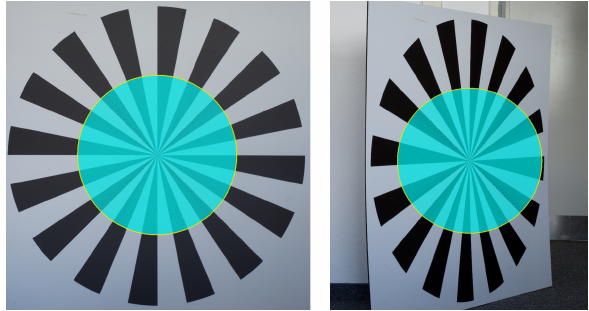
Figure 2. Orthogonal image acquisition configuration (left), inclined image acquisition configuration (right)